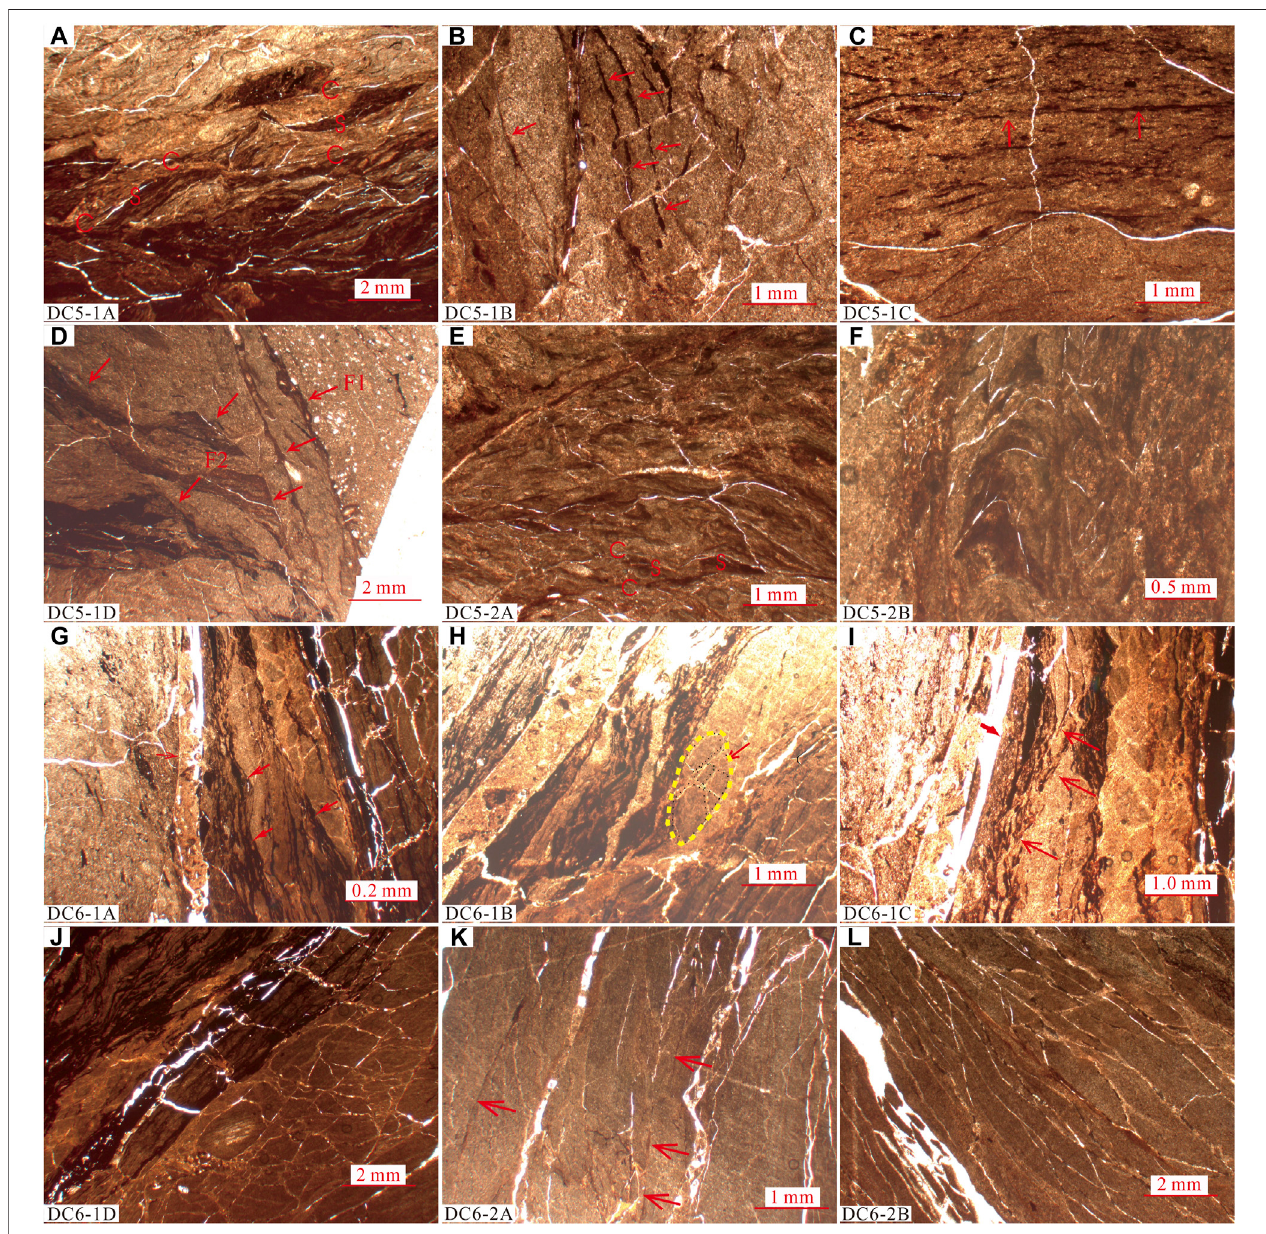
FIGURE 6 | Photomicrographs of samples DC5-1 (A – C) , DC5-2 (D – F) , DC6-1 (G – J) , and DC6-2 (K,L) . S and C denote quasi-S-C fabrics, and arrows indicate cracks or fracture cleavage. Yellow dashed lines mark reworked